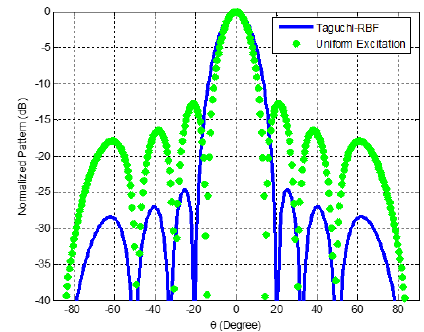
FIGURE 20. Radiation patterns of 8 Antipodal Vivaldi antenna@0° ,and frequency 5.8 GHz.